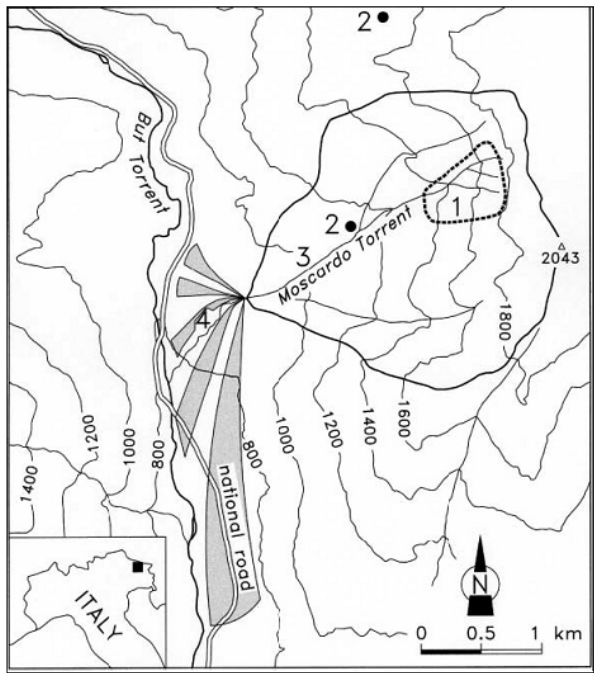
Figure 4. Upstream lymnograph of the debris flow occurred on July 23, 2004 4